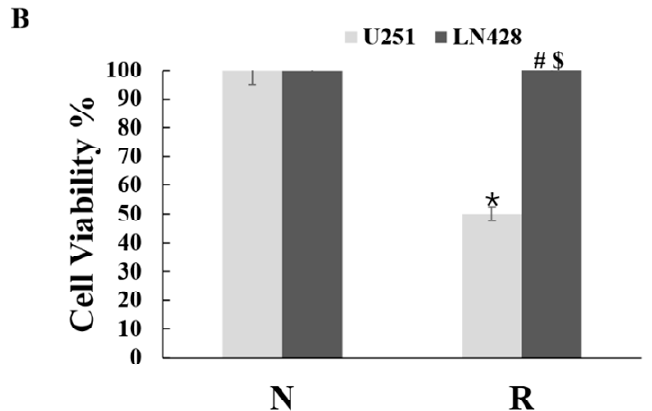
Figure 1. Distinct response of U251 and LN428 to resveratrol. ( A ) Hematoxylin and eosin morphological staining performed on U251 and LN428 cells without (N) or with treatment of 100 μ M resveratrol (R) for 48 h (×100). Resveratrol causes growth arrest and apoptosis of U251 but not LN428 cells. ( B ) Evaluation of the cell viability of U251 and LN428 cells to resveratrol at 100 μ M for 48 h by MTT assay, U251/N vs. U251/R, *, p = 0.4 × 10 − 4 , LN428/N vs. LN428/R; #, p = 0.302; LN428/R vs. U251/R, $, p = 3 × 10 − 4 .